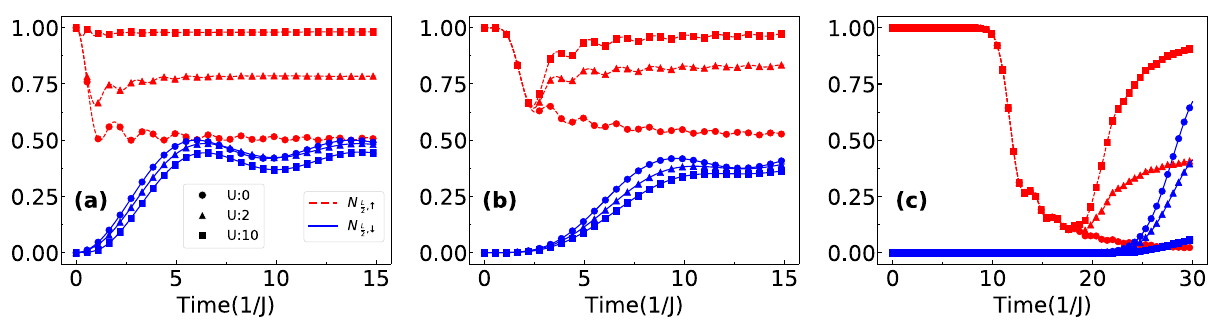
Figure 10. Evolution of half-length occupation N L different interaction strengths such as U = 0 (circles), U = 2 (triangles) and U = 10 (squares). ( a – c ) Correspond to the initial states given in Eqs. (11), (12) and (13) respectively. For ( a – b ) δ = 0.2 and for ( c ) δ = 0.4 is